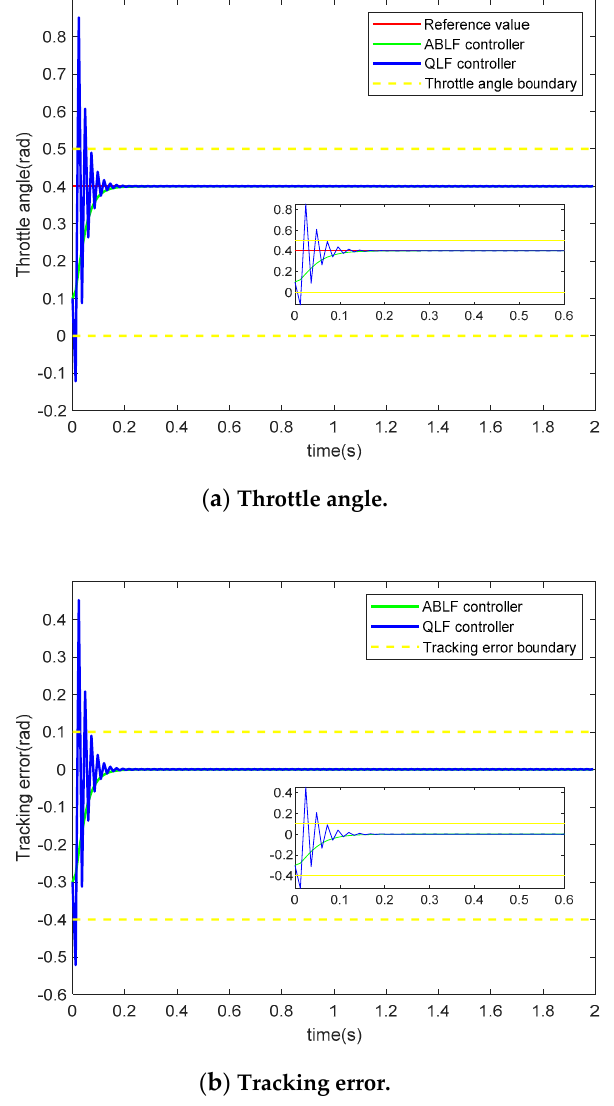
Figure 3. Simulation results under step signal: ( a ) Throttle angle, ( b ) Tracking error.